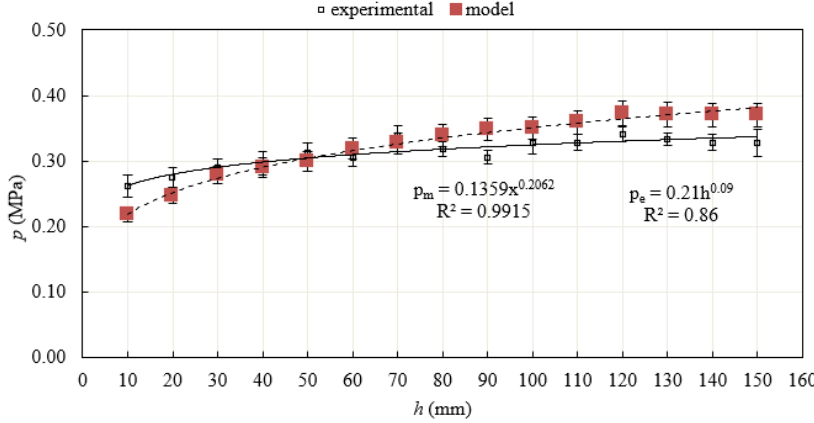
Figure 6. Influence of drop height on the experimental and model values of surface pressure, for wood type substrates. pm —means model surface pressure, pe —means experimental surface pressure. Error bars represent mean ± SD (standard deviation).